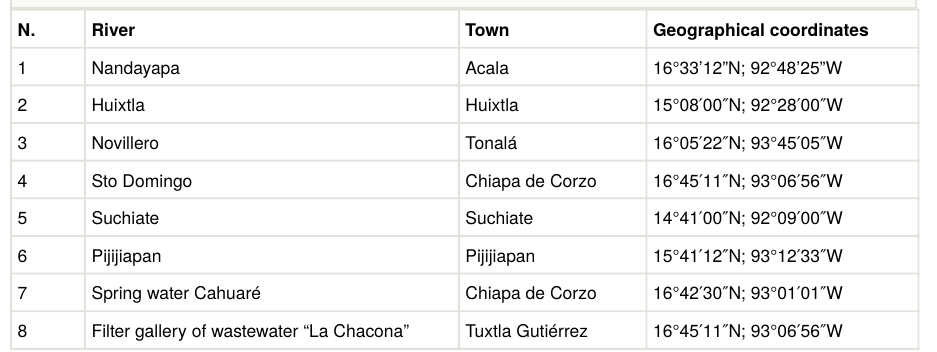
Distribution of sample collection of the di ff erent hydrographic zones of the state of Chiapas,